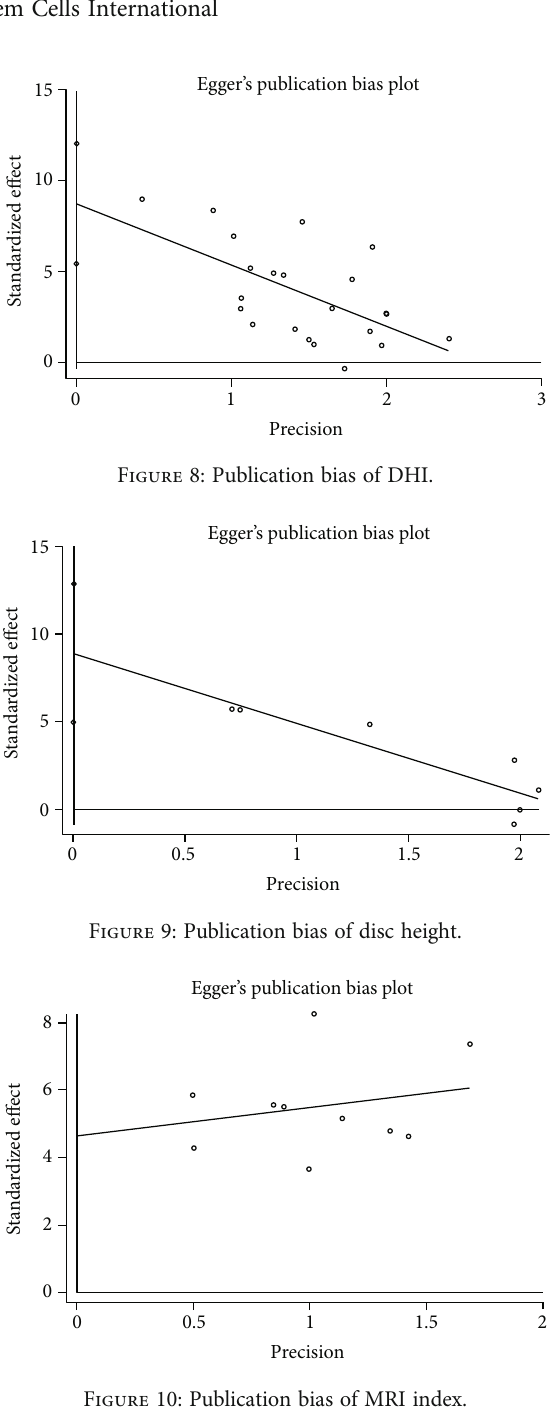
Figure 10: Publication bias of MRI index.